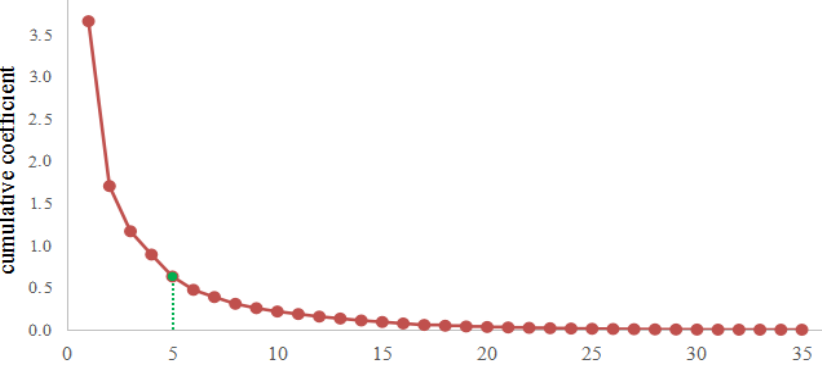
Figure 2. Social-technical sustainability indicators line graph of the cumulative coefficient.